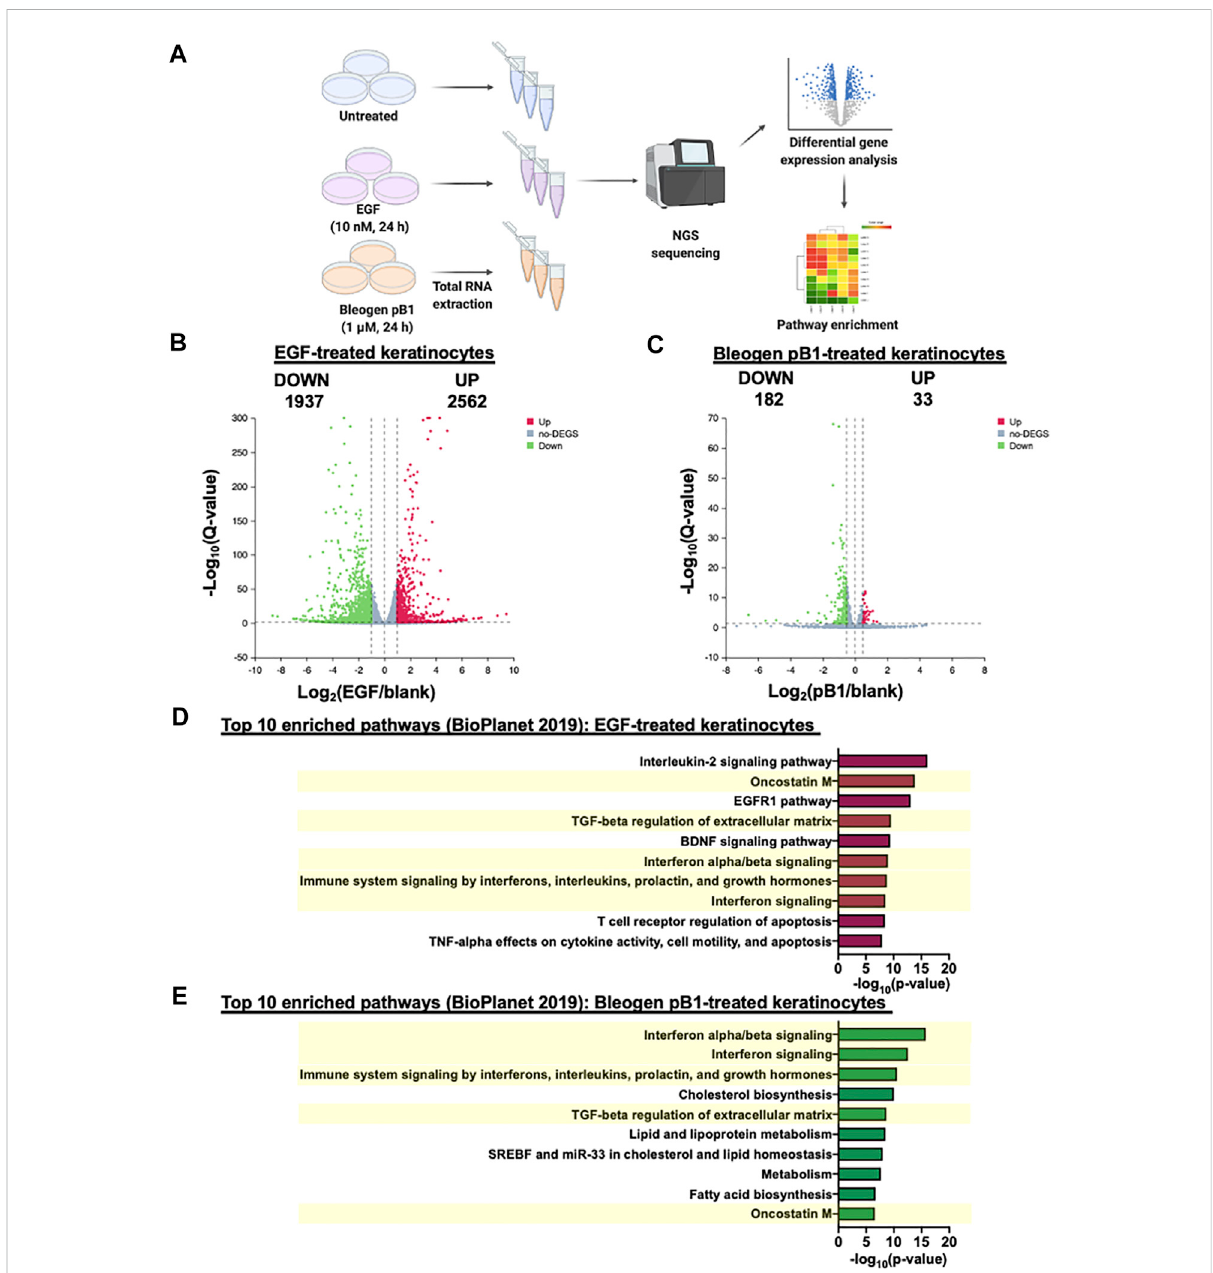
FIGURE 7 (A) Differential gene expression analysis based on the transcriptome pro fi les of HaCaT keratinocytes after treatment ( n = 3) with bleogen pB1 (1 μ M; 24 h) or epidermal growth factor (EGF) (10 nM; 24 h) (B) Volcano plot displaying the differentially expressed genes (DEGs) in HaCaT cells, as inducedbyanEGFtreatment(10 nM)for24 h (C) VolcanoplotdisplayingtheDEGsinHaCaTcells,asinducedbyatreatmentwithbleogenpB1(1 µM) for 24 h (D) Pathway enrichment analysis of the differentially expressed HaCaT cell genes induced by an EGF treatment (10 nM; 24 h), as performed by using the BioPlanet 2019 database and the enrichR bioinformatics package (E) Pathway enrichment analysis of the differentially expressed HaCaT cell genes induced by a bleogen pB1 treatment (1 μ M; 24 h), as performed by using the BioPlanet 2019 database and the enrichR bioinformatics package. The yellow box highlights the common pathways among the top 10 enriched pathways that were found to be shared between the EGF and the bleogen pB1